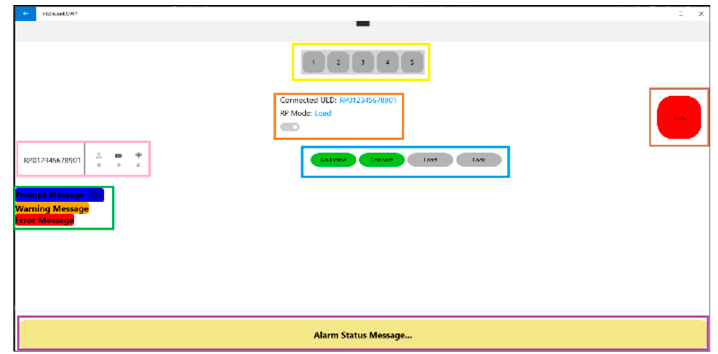
Figure 13. Robotic Platform Page.